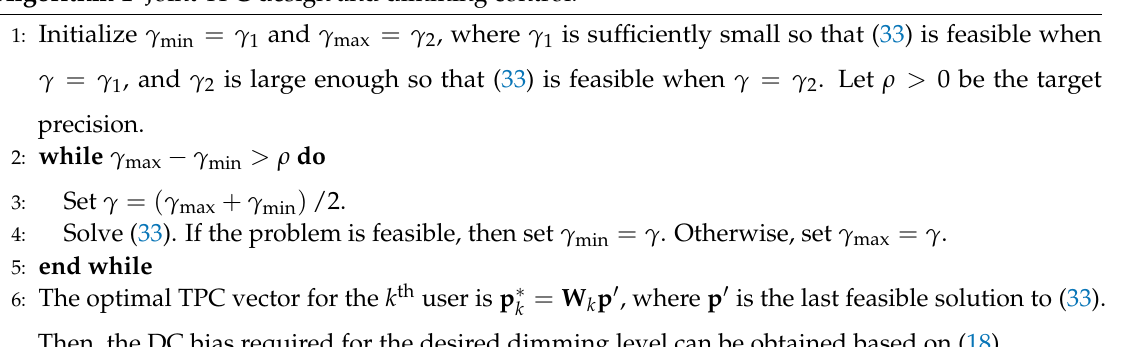
Algorithm 1 Joint TPC design and dimming